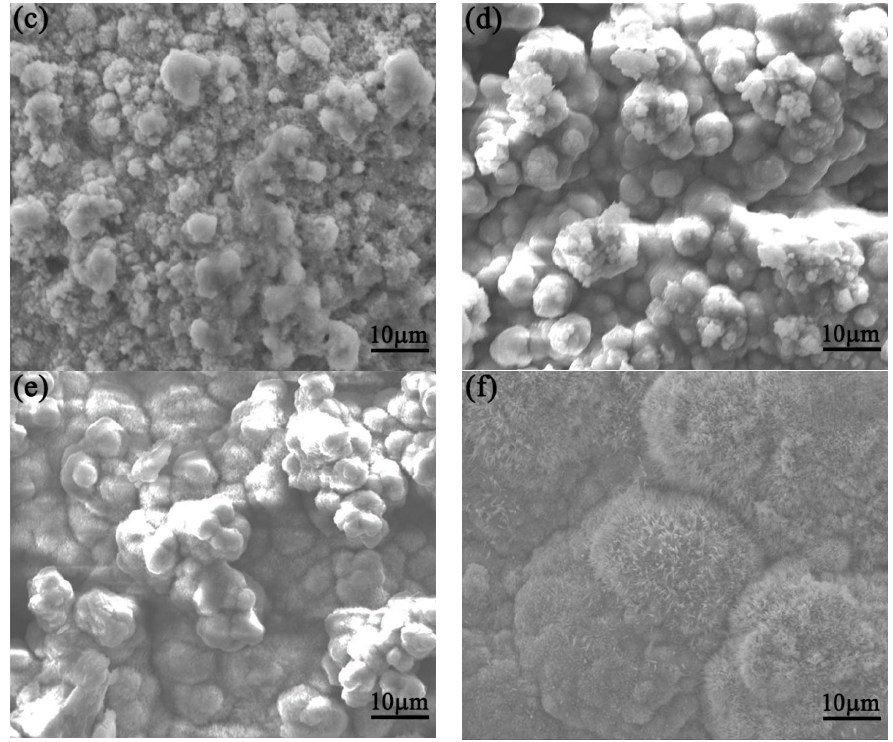
Figure 3. SEM morphologies of the tested medium manganese steel after different immersion durations: ( a ) 24 h; ( b ) 72 h; ( c ) 168h; ( d ) 288 h; ( e ) 432 h; and ( f ) 600 h.